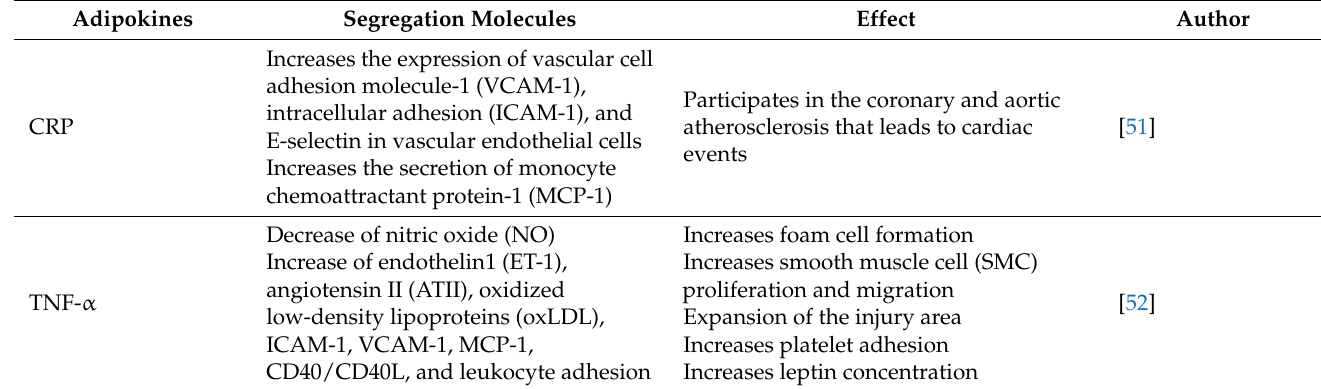
Figure 2. Leptin pathway. Leptin binds to the ObR receptor and JAk-2 transphosphorylation occurs, translocating the phosphate groups, giving rise to the anchoring and phosphorylation of STAT3. These STA3 travel to the nucleus, where the transcription of target genes, such as POMC (decreases hyperphagia) and AgRP (increases food intake), takes place. This pathway can be inactivated by the interaction of tyrosine-protein phosphatase 3 (PTP3) and suppressor of cytokine signaling 3 (SOCS3), causing resistance to leptin, resulting in hyperleptinemia, which leads to cardiovascular problems, such as hypertension, as well as causing a decrease in insulin secretion in β cells. Created with BioRender.com. Table 1. Adipokines’ effect on obesity.